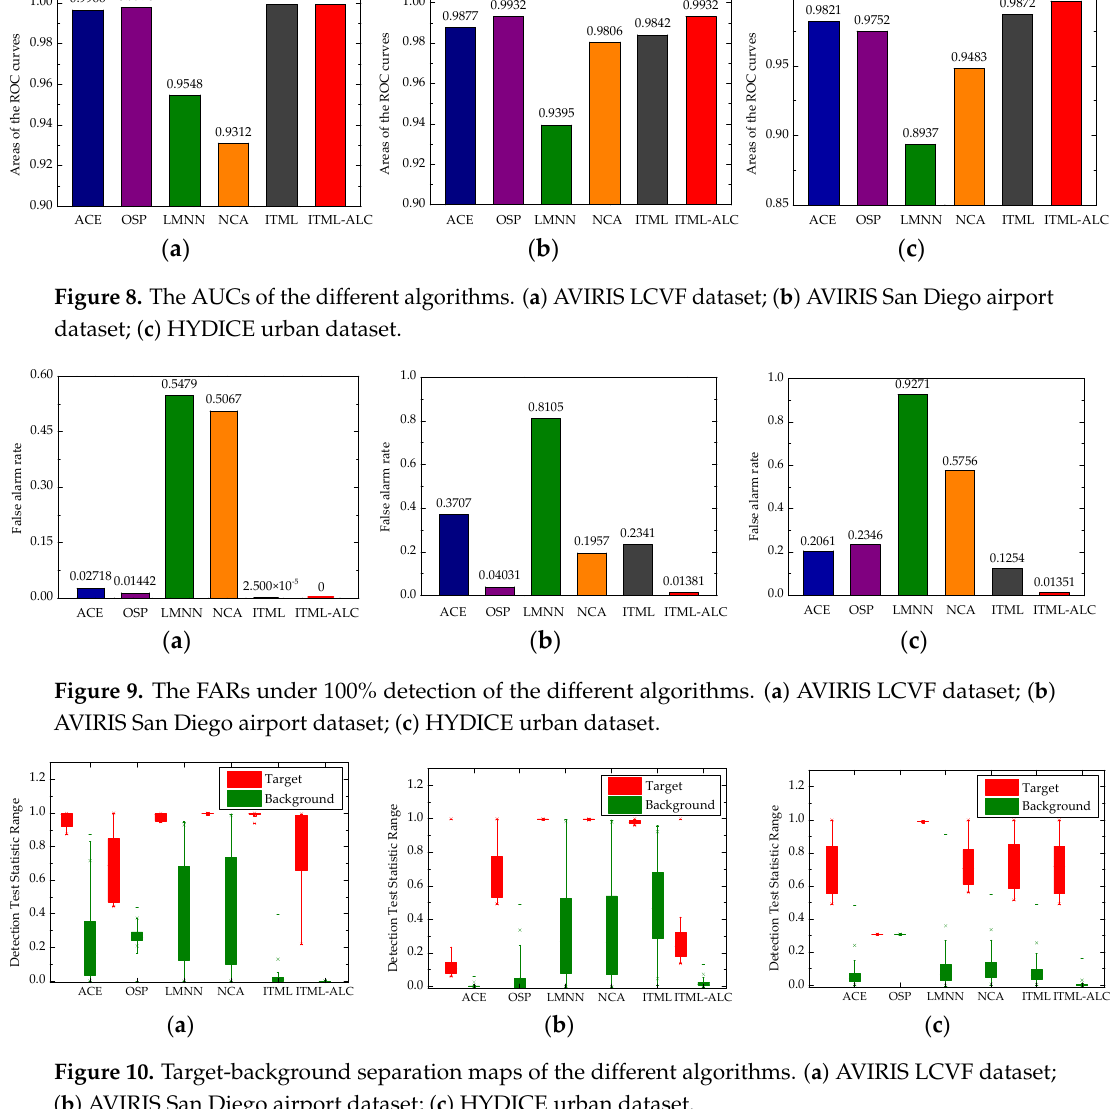
Figure 10. Target-background separation maps of the different algorithms. ( a ) AVIRIS LCVF dataset; ( b ) AVIRIS San Diego airport dataset; ( c ) HYDICE urban dataset. 4. Discussion In this paper, the proposed ITML-ALC algorithm is employed to transform the original feature space into the metric feature space by introducing adaptively local constraints to the ITML model.